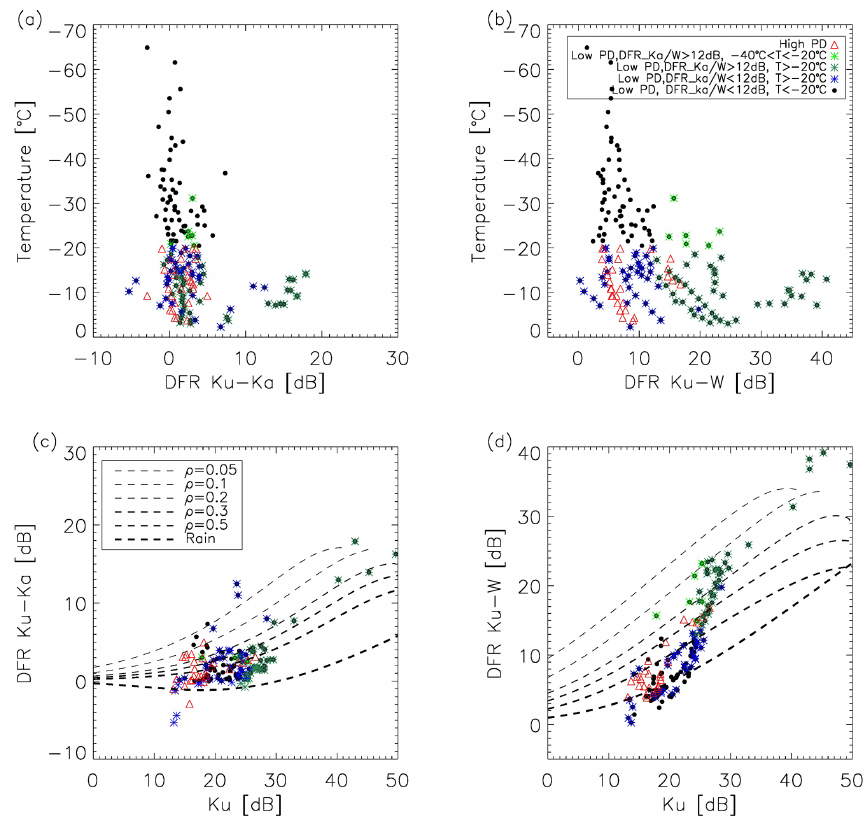
Figure 7. Scatter plots of the DFR relationship to temperature (a, b) and to reflectivity (c, d) for high-PD observations (red triangle), low PD with cold temperature and small DFR Ku / Ka (black dots), low PD with warm temperature and small DFR Ku / Ka (blue asterisks), low PD with cold temperature and large DFR Ku / Ka (green asterisks), and low PD with warm temperature and large DFR Ku / Ka (green-blue asterisks). Theoretical calculation of density isolines are overlaid in (c, d) to facilitate our understanding of the density (and habit) of each group of ice